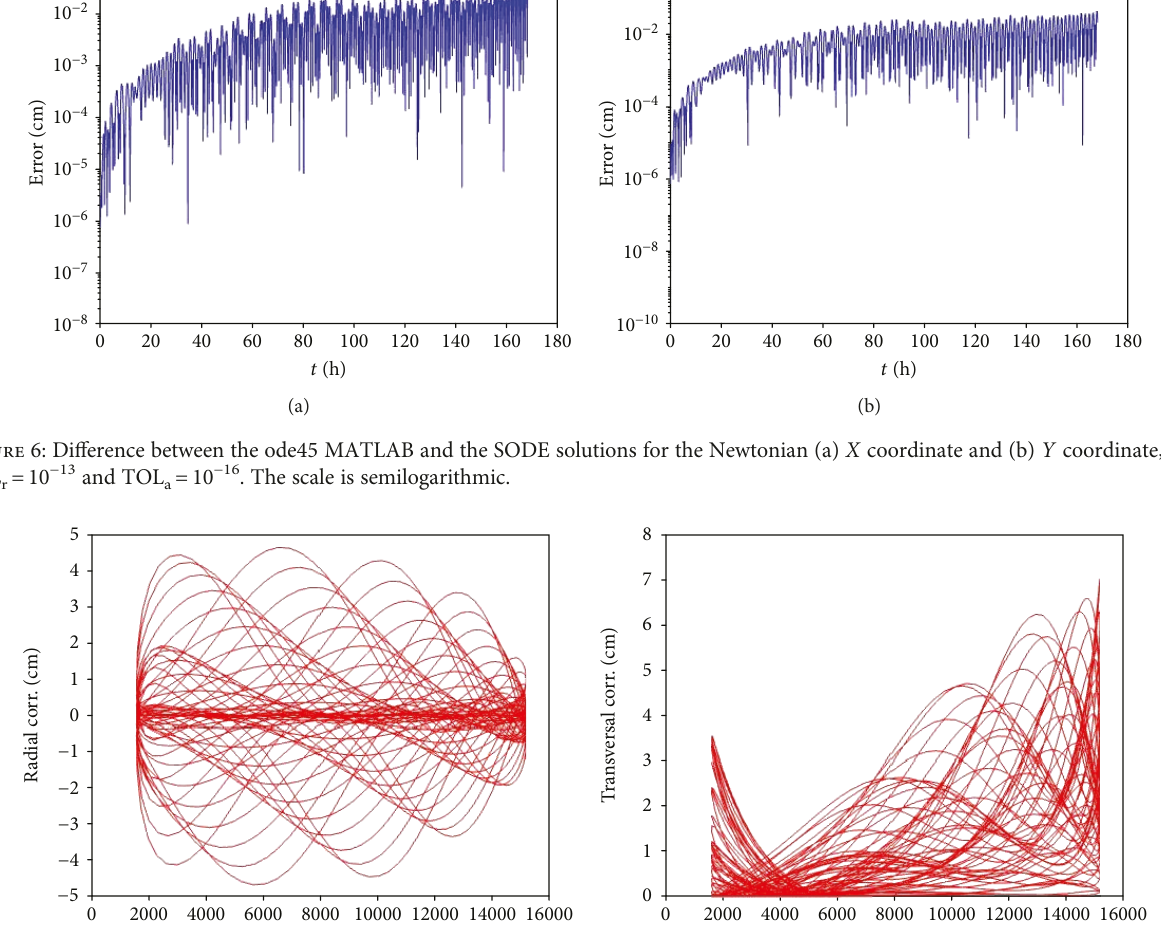
=10 − 13 and TOL =10 − 16 . r a